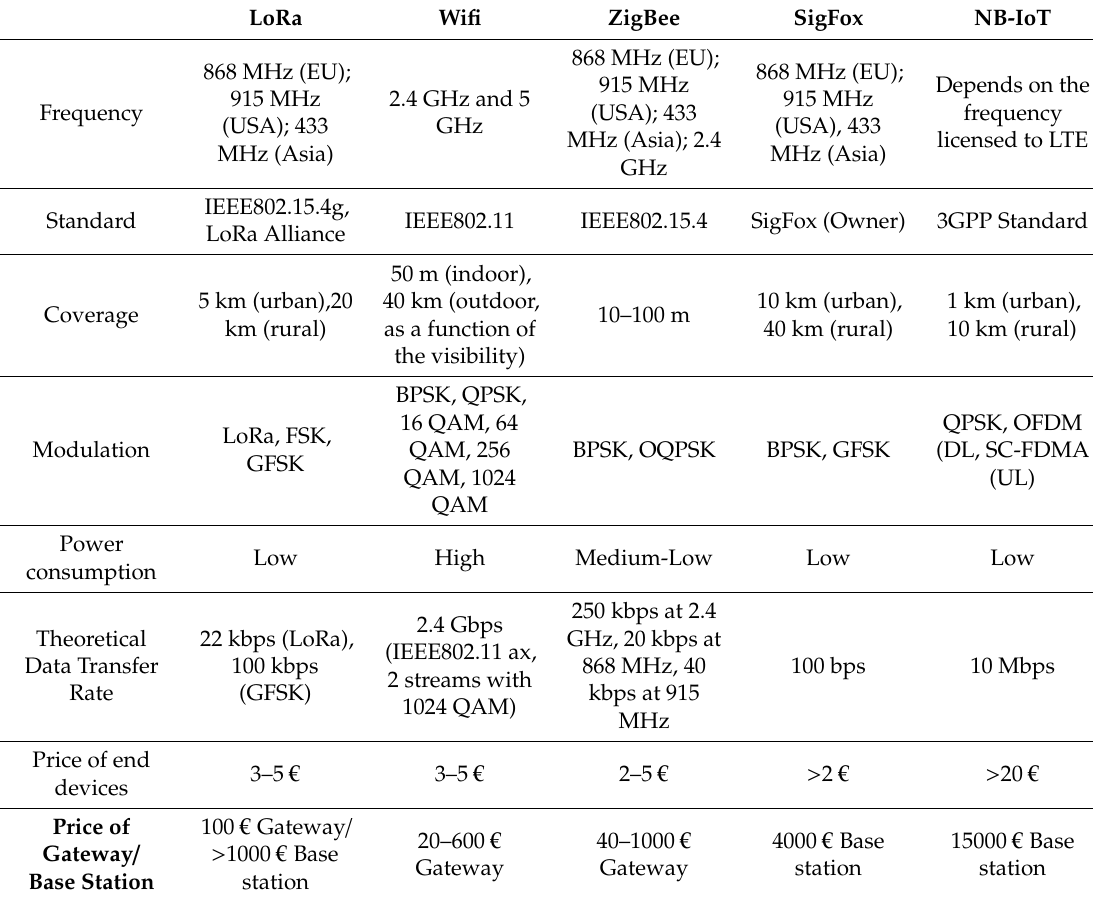
Table 1. Comparison of technologies used in